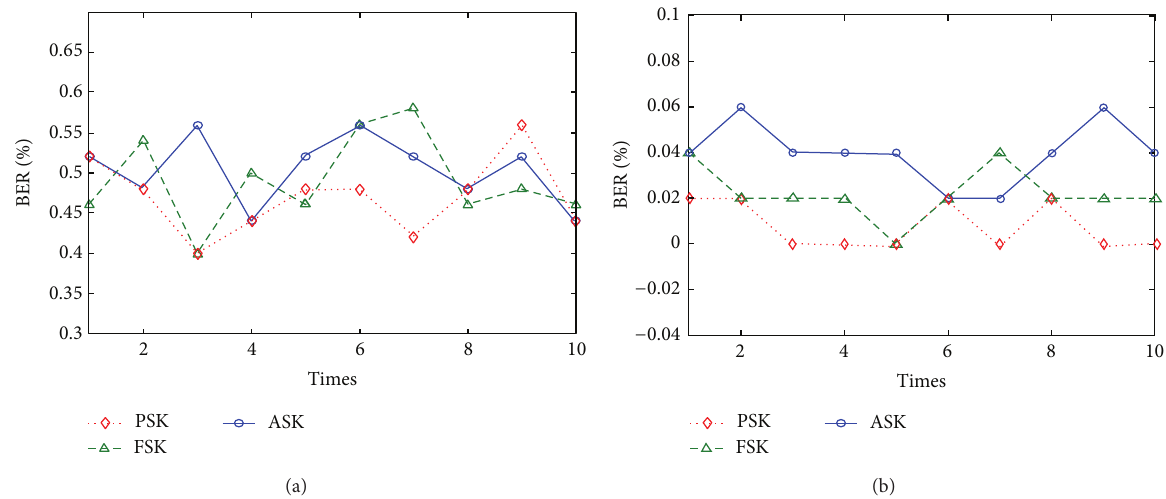
Figure 8: The BER simulation curves of ASK-, FSK-, and PSK-modulated data in either a single- or a dual-receiver mode. (a) Single-receiver mode and (b) dual-receiver mode.